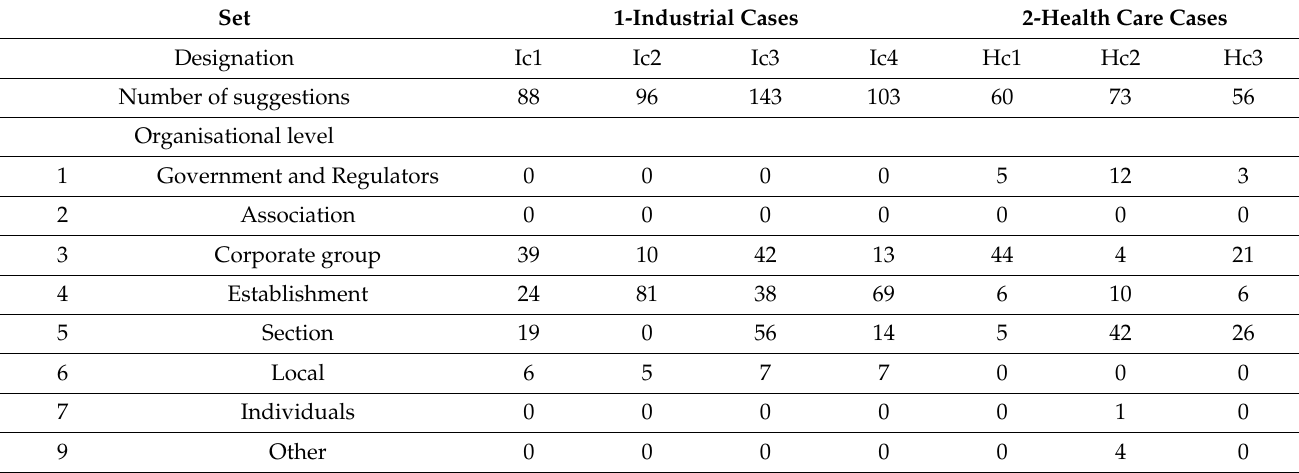
Table 4. Distribution on organisational levels of reforms from the combined method approach.